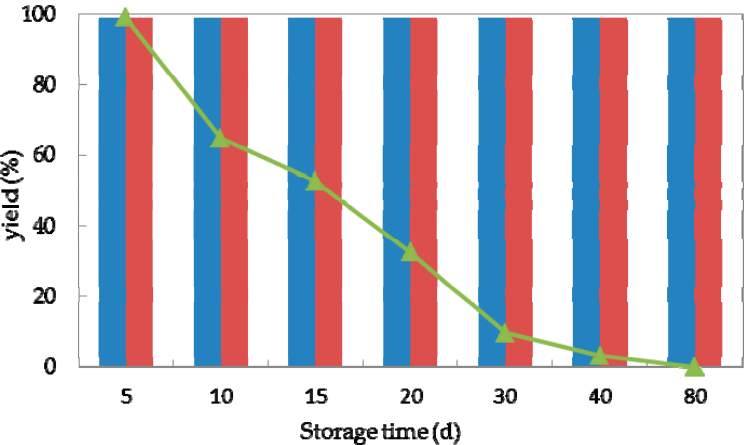
Figure 5. Storage stability of free cells (represented by the triangles), immobilized cells on agar (represented by the red striped bar) and calcium alginate (represented by the blue striped bar) of G. candidum AS 2.361 catalyzing the reduction of 1-(2-bromophenyl)ethanone ( 1a ) at 4 °C.